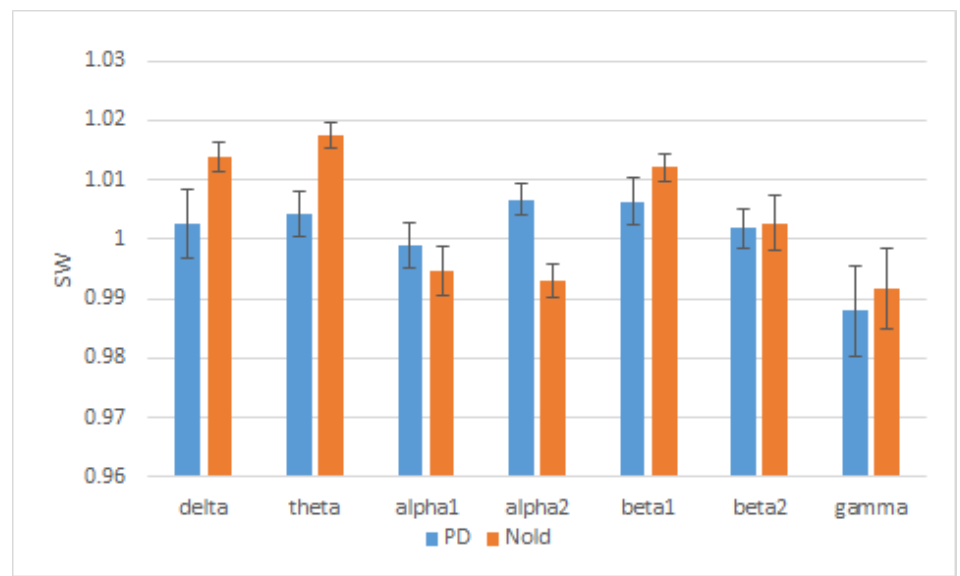
Figure 5. SW index trend in PD patients (blue line) and healthy elderly subjects (red line) in EEG frequency bands (delta, theta, alpha 1, alpha 2, beta 1, beta 2, and gamma). Adapted from [21].